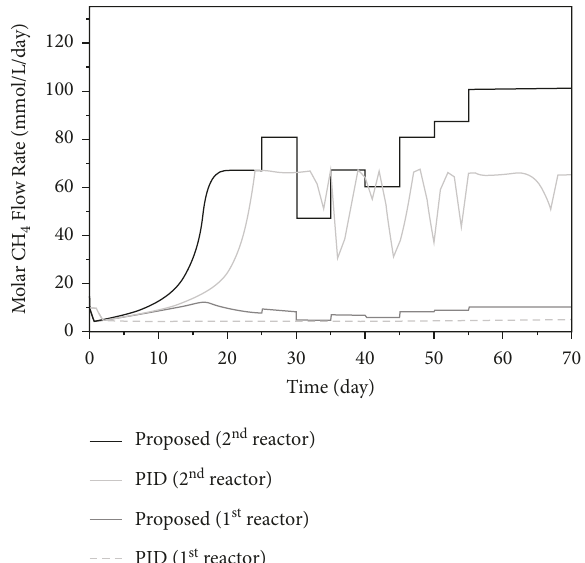
Figure 10: The responses of methane production rate under the condition with changes in the bacterial maximum growth